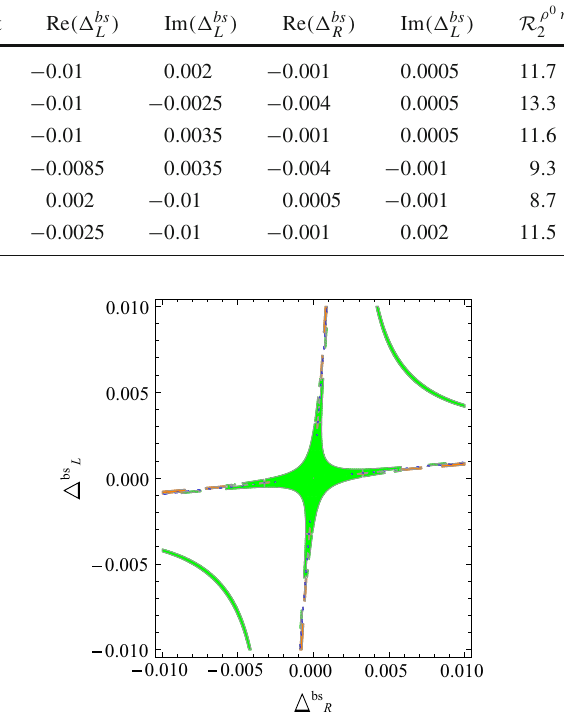
< 10, 10 < X < 100 and 100 < X B s s